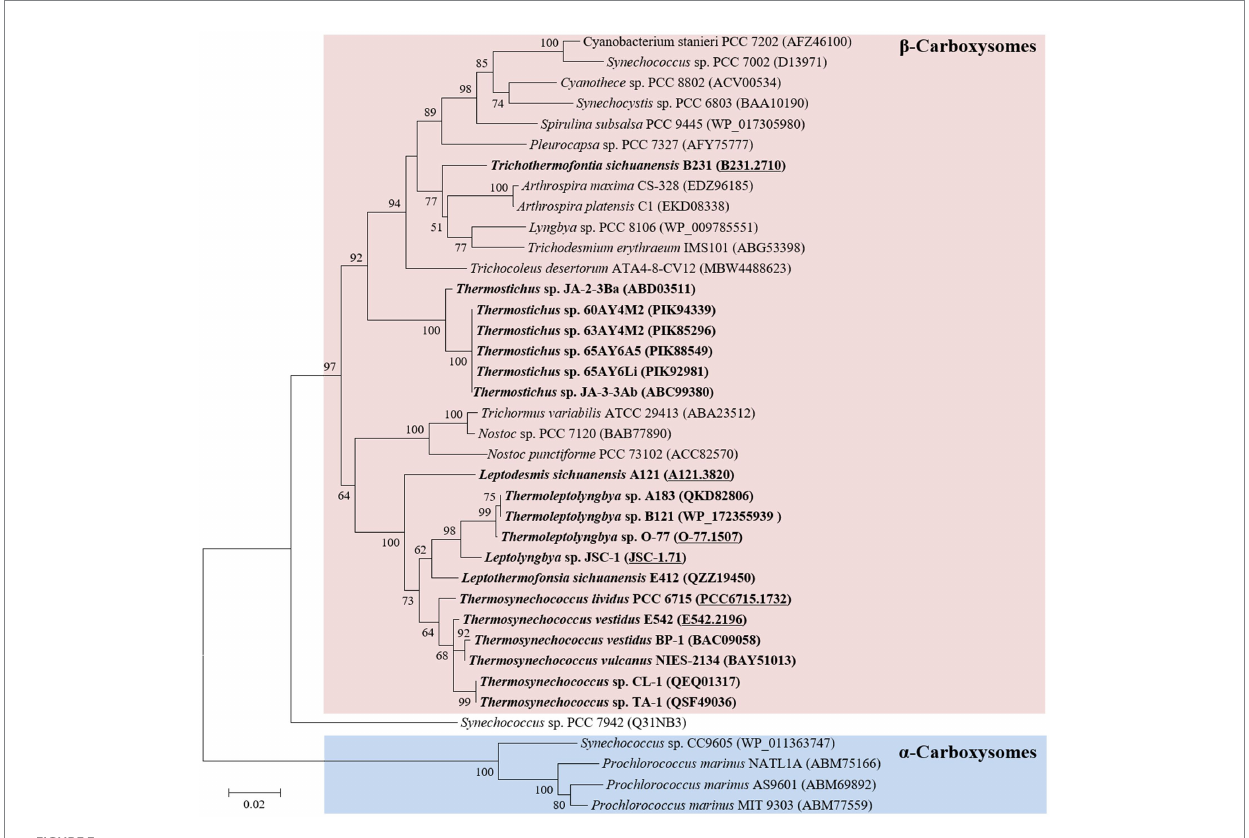
FIGURE 3 ML phylogenetic inference of RubisCO large subunit protein sequences. The thermophilic cyanobacterium investigated in this study and previously reported thermophiles are indicated in bold. The accession numbers underscored refer to the gene IDs in Supplementary Table 1 or the reference (Tang et al., 2022d).